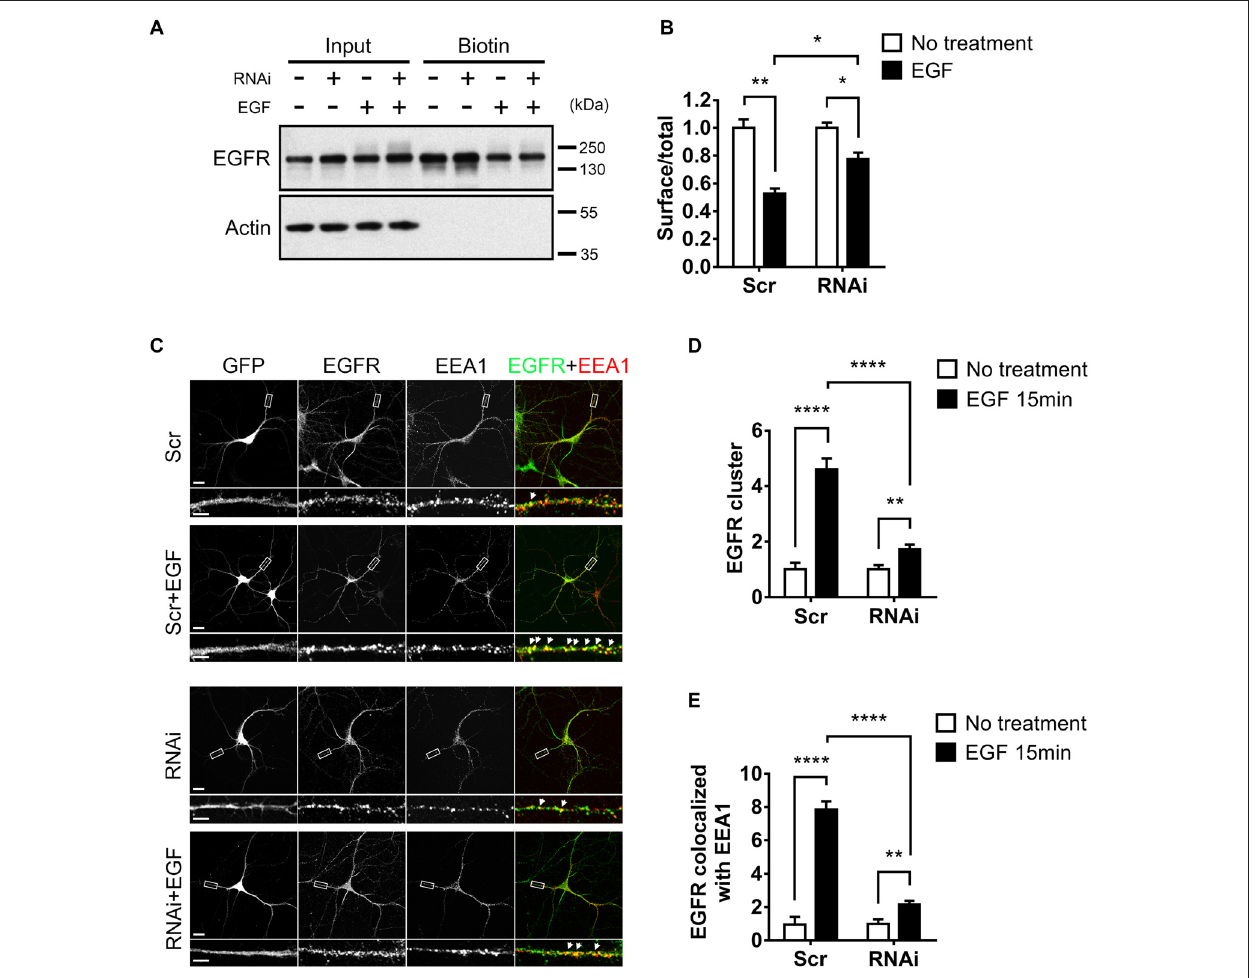
FIGURE 4 | HIP1R knockdown affects the internalization of EGF receptor (EGFR). (A) Total and surface EGFR expression after EGF stimulation in cultured hippocampal neuron at DIV 12. (B) Quantification of EGFR expression. (C) Representative images of neurons, with or without EGF stimulation. GFP (gray), EGFR (green) and early endosomal autoantigen 1 (EEA1; red). GFP indicates successful transfection of Scrambled-RNAi or HIP1R-RNAi. Filled white arrows showed colocalized EGFR and EEA1 clusters. Scale bar, 20 µ m for whole cell and 10 µ m for partial enlarged detail. (D,E) Quantification of EEA1-colocalized EGFR clusters ( n = 22 neurons for Scrambled, 23 neurons for Scrambled+EGF, 25 neurons for RNAi, and 25 neurons for RNAi+EGF groups). Mean ± SEM; ∗ p < 0.05; ∗∗ p < 0.01; ∗∗∗∗ p < 0.0001; three independent experiments; unpaired two-tailed t